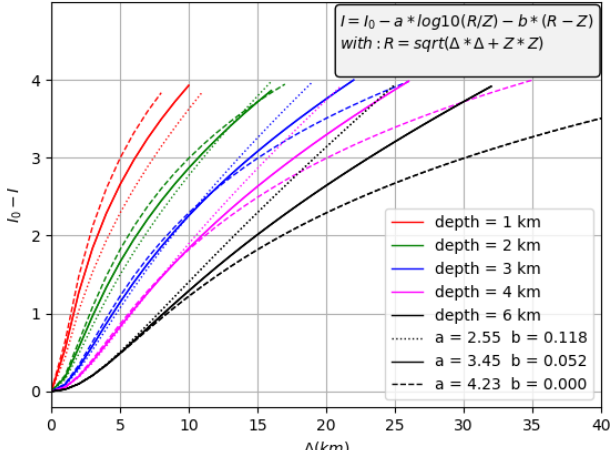
Figure 6. Variation of I 0 − I as a function of epicentral distance cor- responding to the intensity attenuation models of Fig. 5. The curves correspond to the best fitting solution (full lines) and the two ex- treme solutions (dotted and dashed lines) at the 0.95 confidence re- gion for focal depths ranging from 1 to 6km.